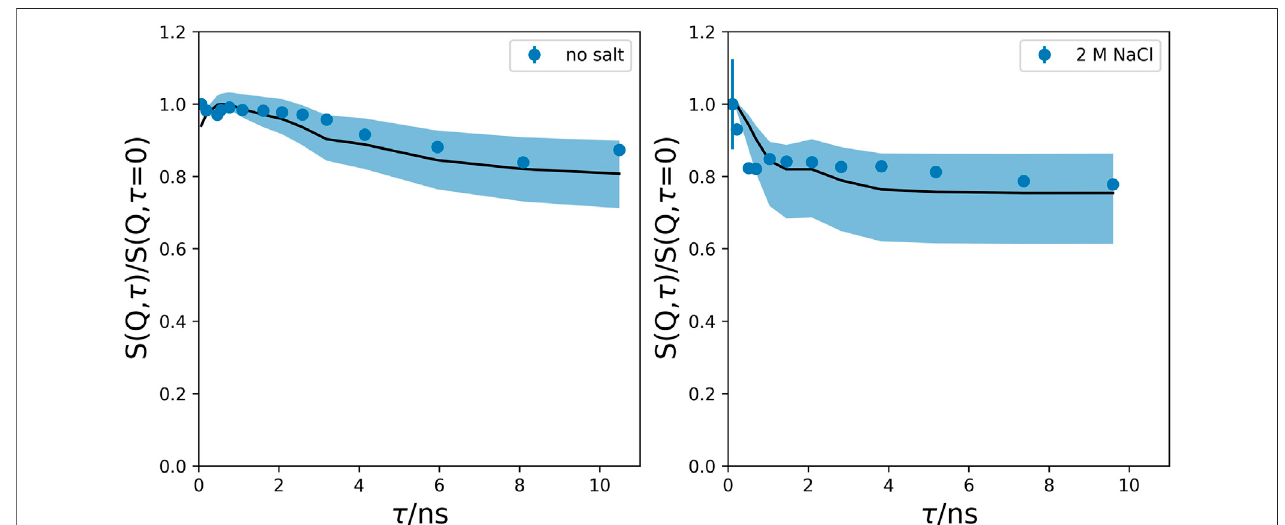
FIGURE2| GINSESdataforsamplewithout (leftpanel) saltandasamplewitha2 MNaClconcentrationinthesolvent (rightpanel) .Theblacklinesrepresentthe dataeithercalculatedfrom fi tsinourpreviouspublication[17].Theshadedareasrepresentthecon fi denceareasusingtheuncertaintiesforthein-planeQ.Theextremely good correspondence, evenwithouta fi t(seetext) corroboratesourearlier and current useofthe Romanov layermodel and theexistence ofthe surfacemode shown in our previous publications. The very fast decay for short times in the case of a 2 M NaCl concentration we attribute to a facilitated sliding of the membrane layers against each other for short